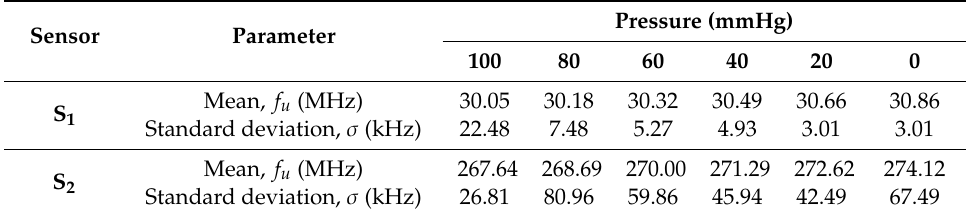
Figure 18. Repeatability of measurements with S 2 over 10 cycles. Table 4. Mean value and standard deviation of measured resonance frequencies when both sensors were tested under different pressures for 10 cycles.